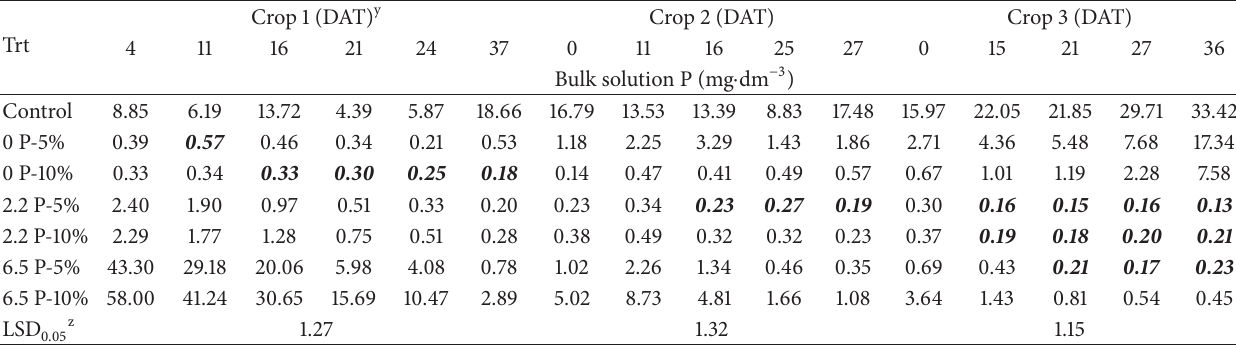
Table 2: Phosphorus concentration in bulk solutions of root media amended with no soil material (control) and six soil material treatment combinations containing 5 or 10% soil material (v: v) charged with 0, 2.2, or 6.5 mg ⋅ g −1 phosphate-P during three successive tomato seedling crops x .